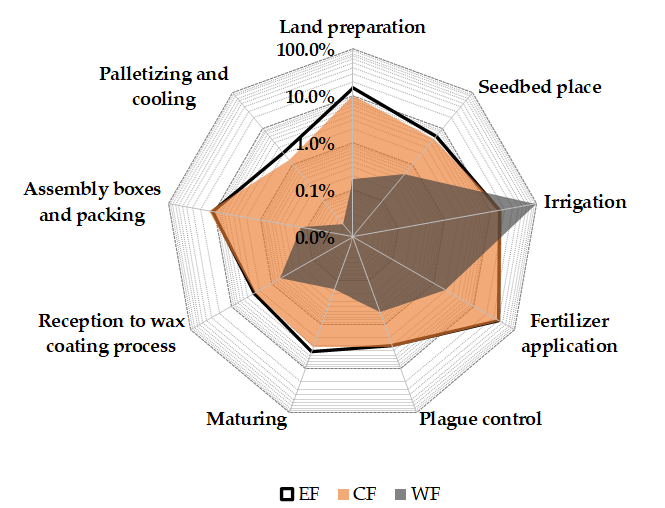
Figure 8. Carbon, water, and energy footprint of pineapples packed by main unit processes.